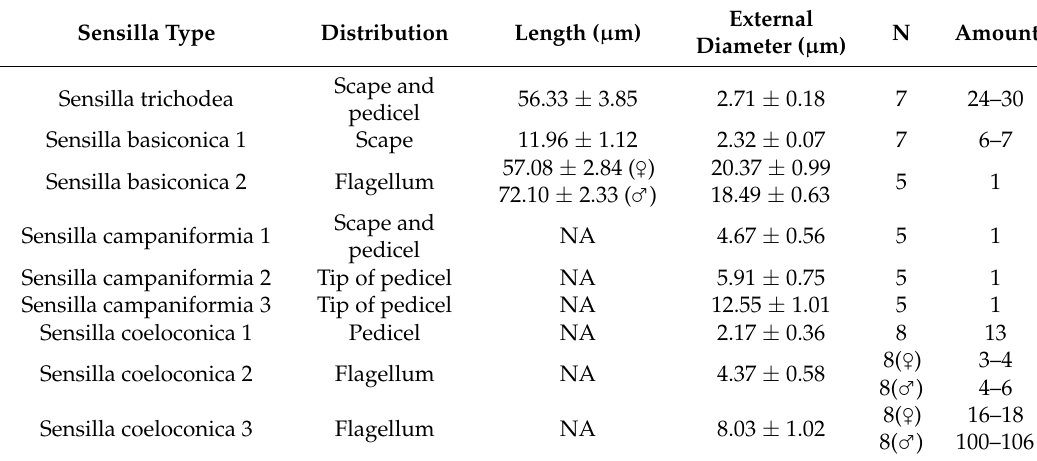
Figure 8. Antennal sensilla on scape and the pedicel of adult Callitettix versicolor (Fabricius). ( A ) Base of scape showing distribution of sensilla basiconica 1; ( B ) High magnification of sensilla basiconica 1 (SB1); ( C ) Sensilla trichodea (ST); ( D ) High magnification image of the base of sensilla trichodea (ST) showing longitudinal grooves. Scale bars: A = 10 μm; B = 5 μm; C = 15 μm; D = 2.5 μm. Table 1. Morphometric data for various antennae sensilla of adult Callitettix versicolor (Fabricius). Data are mean ± SE values obtained from scanning electron microscopy. N = sample number; NA: not applicable.